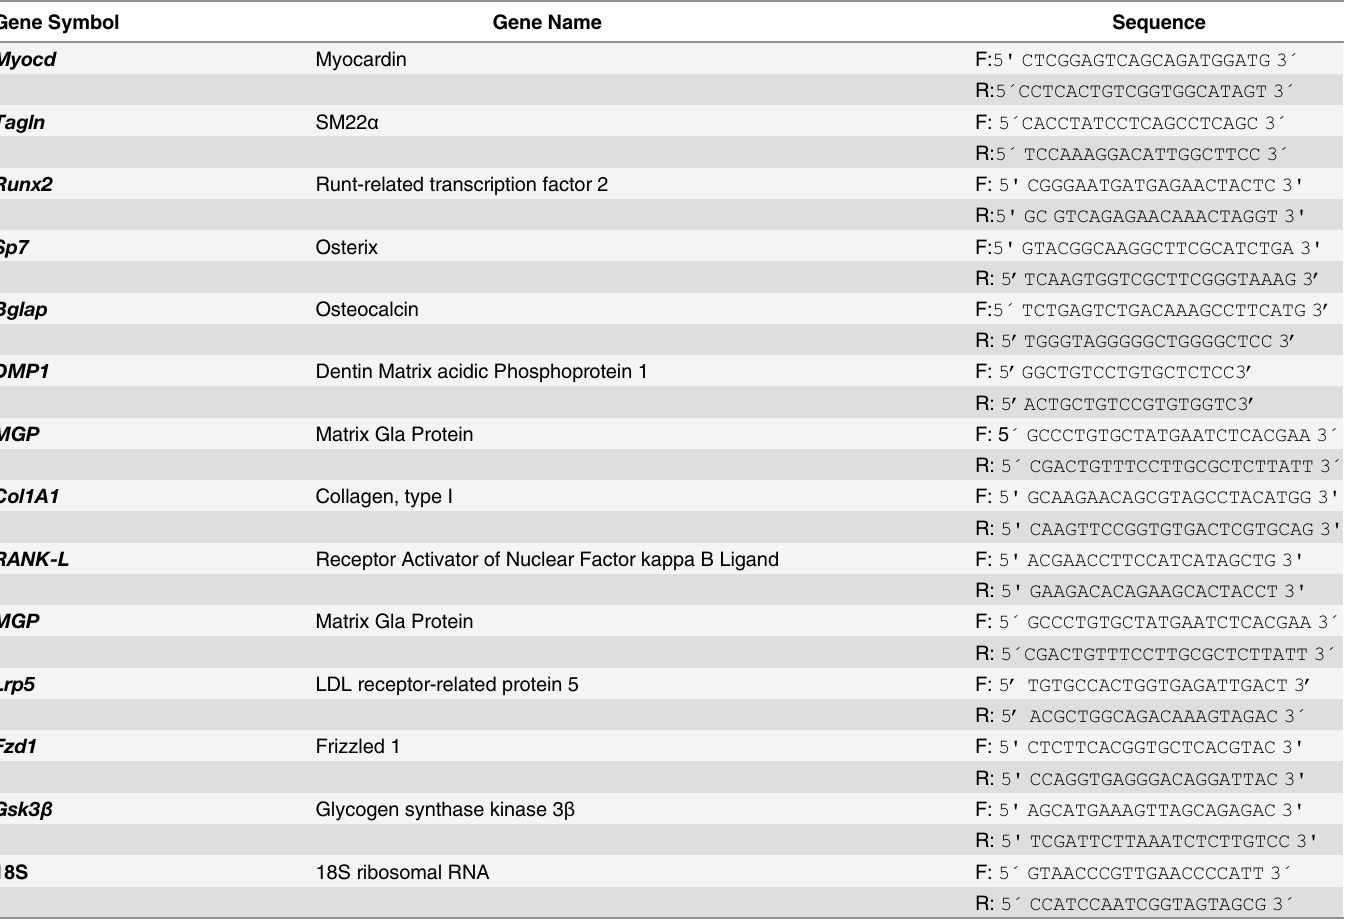
Table 1. Primer sequences used for